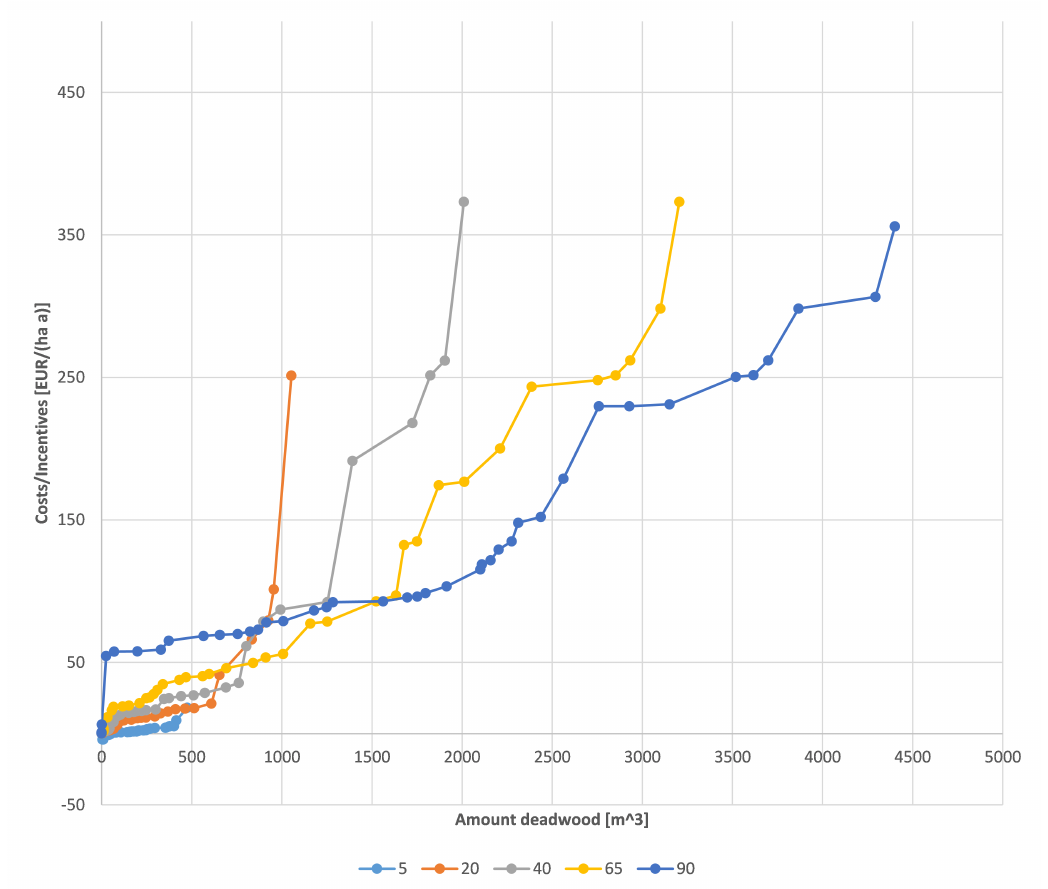
Figure 7. Forest enterprise “Eichelberg”: Costs or necessary compensations (incentives) in [ e ha − 1 a − 1 ] of absolute deadwood amounts in [m 3 ], to be maintained within 30 years, using crown material of beech. The different colours correspond to the average deadwood volume from 5m 3 ha − 1 to 90m 3 ha − 1